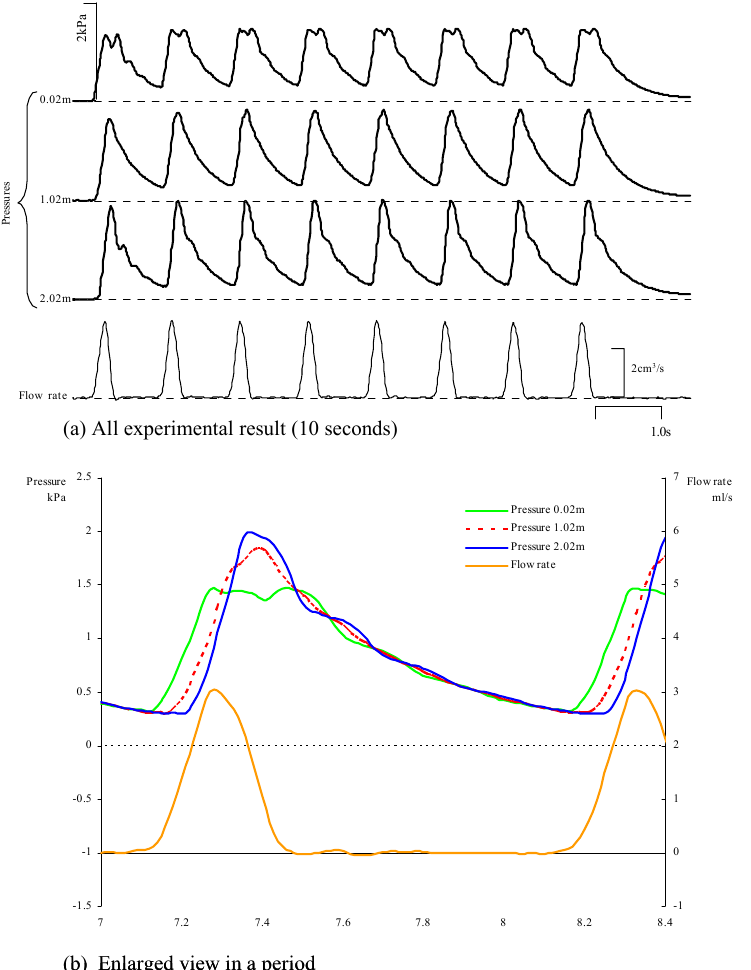
Fig. 6 Time profiles of pressure waves at three positions in the tube and flow volume into the